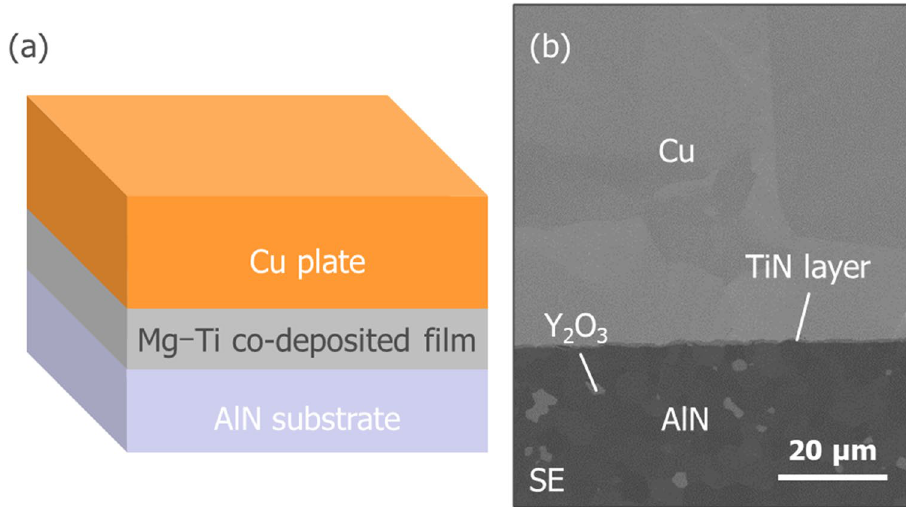
Fig. 1 a Schematic illustra- tion of the Cu/AlN interface fabricated in this work. b Cross-sectional SE image of the Cu/AlN interface bonded at 800 °C for 0.5 h with w Mg = 1.04 mg/cm 2 and w Ti = 0.14 mg/cm